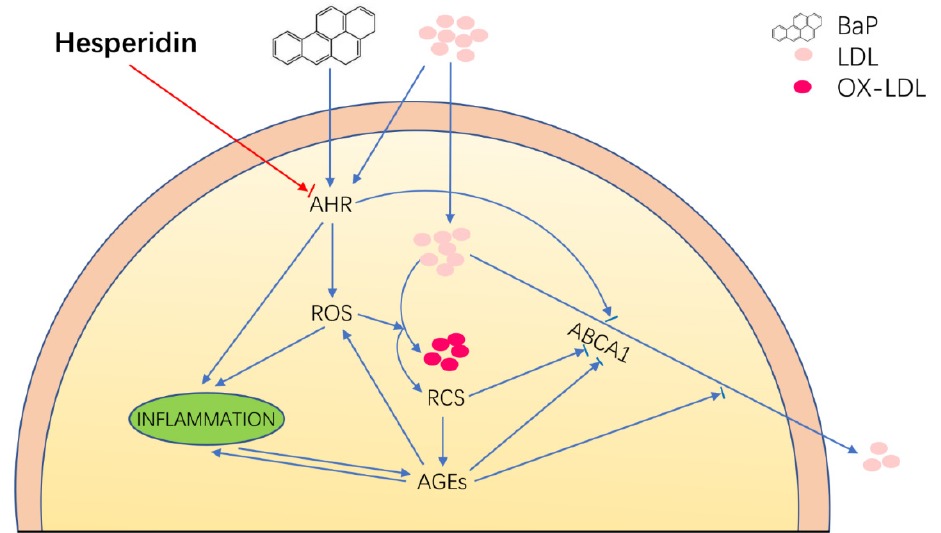
Figure 4. Proposed schematic representation of Hesperidin’s multifaceted protective effects in EA.hy926 cell injury induced by BaP depending on the AHR pathway. The blue indicator line represents the injury response caused by BaP and LDL to EA.hy926 cells, and the red indicator line represents the therapeutic effect of Hsd on EA.hy926 cells injury caused by BAP and LDL. The arrow shows an increase to this indicator’s expression, and the short line before the arrow shows inhibition. Hesperidin attenuated the endothelial cell injury induced by BaP, depending on the AHR-mediated pathway through anti-inflammatory, antioxidant, and enhancing reverse cholesterol transport. Table S2: row date of CYP1A1mRNA (RT-qPCR, Figure 1C,D), Table S3: row date of ABCA1mRNA (RT-qPCR, Figure 1G). Table S4: row date of MDA (Figure 1E,F). Table S5: row date of IL-1 β mRNA (RT-qPCR, Figure 3B,C). Figure S1: Raw images of western blot for